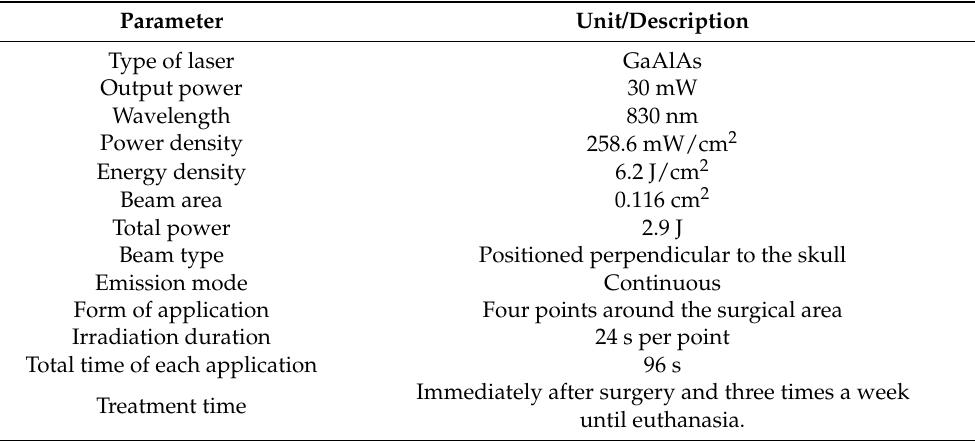
Table 1. Protocol of photobiomodulation therapy. Parameter Unit/Description Type of laser GaAlAs Output power 30 mW Wavelength